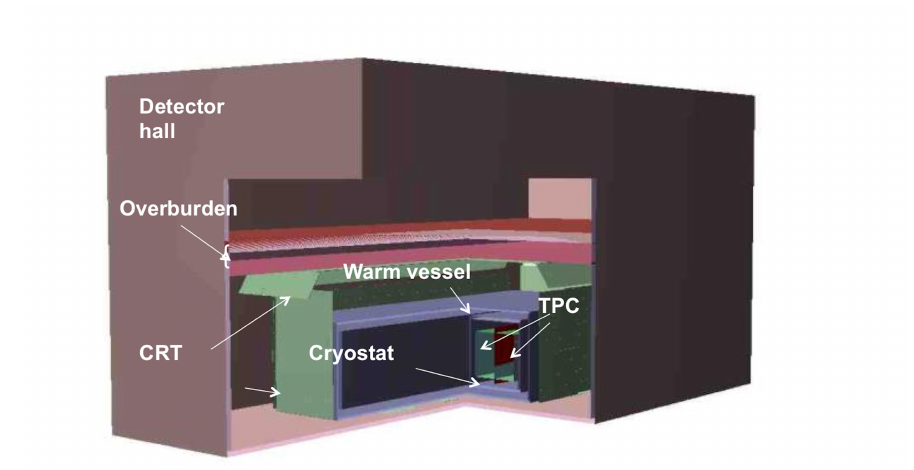
Figure 6. Sketch of the new geometry description of the T600 detector in LarSoft.